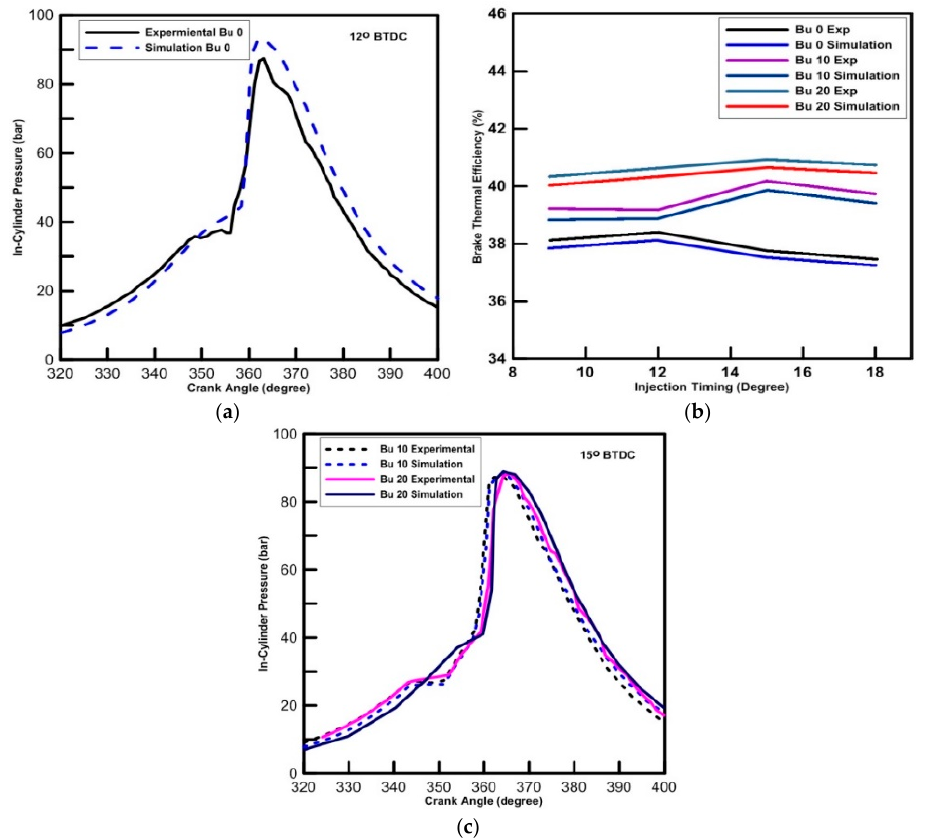
Figure 2. ( a ) The c omparison of in-cylinder pressure between numerical and experimental for diesel (BU0); ( b ) the comparison of BTE between numerical and experimental for BU0, BU10, and BU20; and ( c ) the comparison of in-cylinder pressure between numerical and experimental for BU10 and BU20.